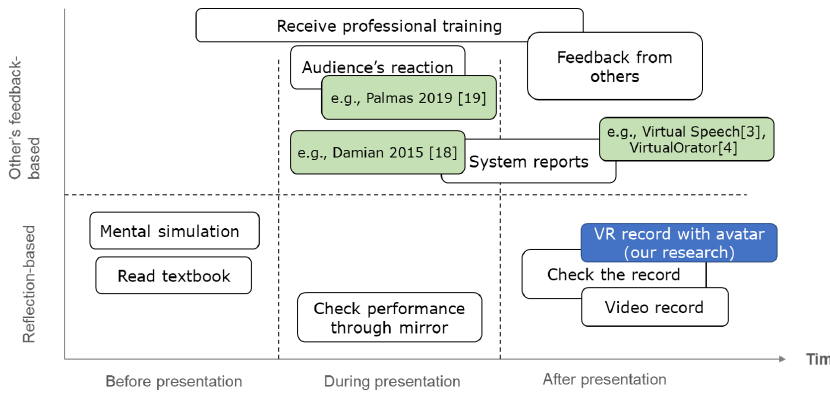
Figure 1. The positioning of this